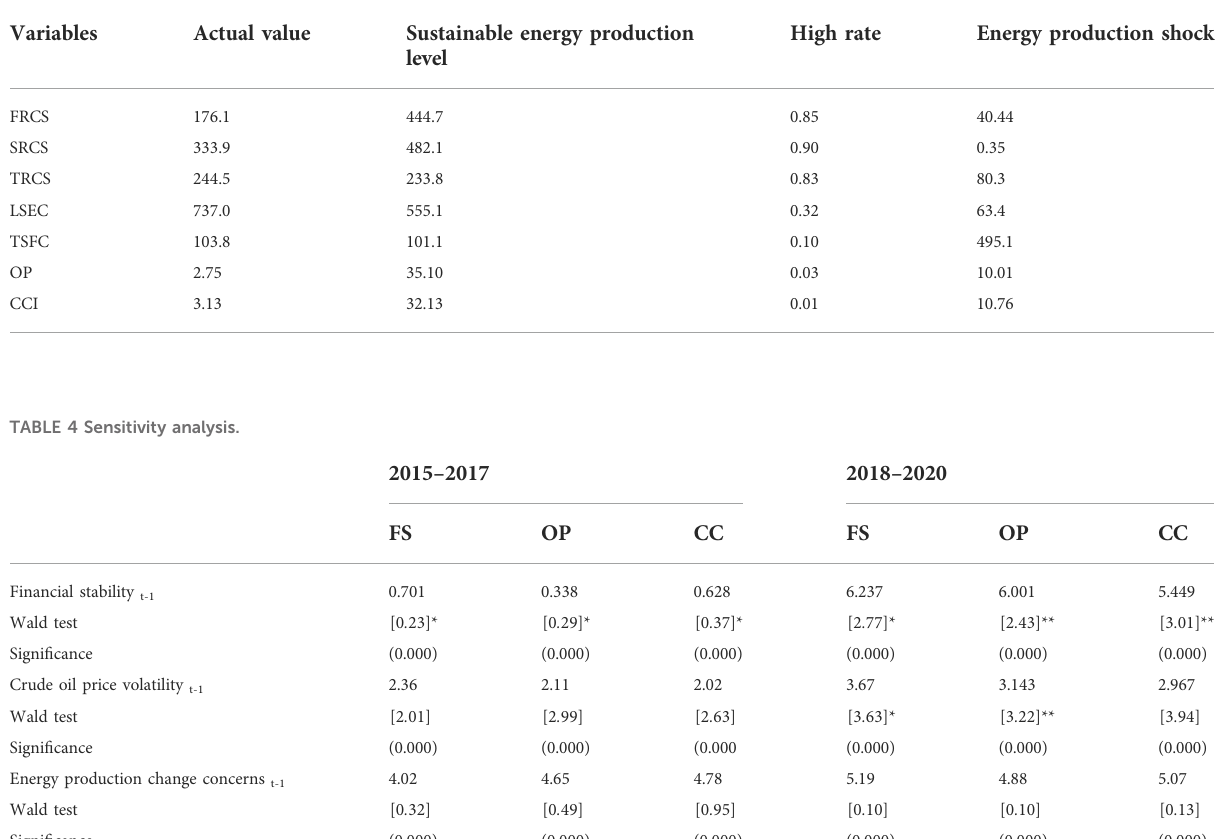
TABLE 3 Empirical parameters of sustainable energy productions of ASEAN economies.